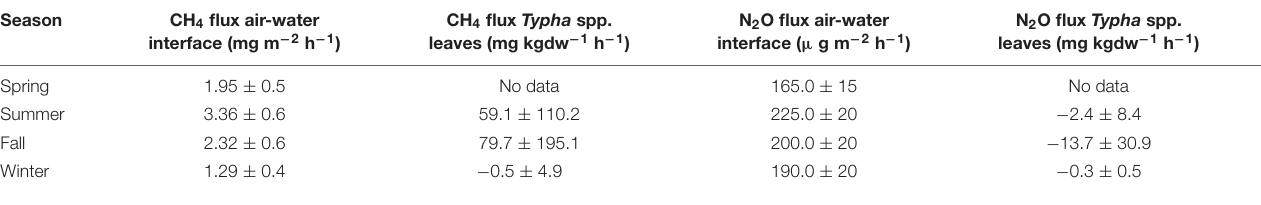
TABLE 3 | Average ( ± SD) of greenhouse gas fluxes from the Tres Rios marshes (Ramos, 2017).